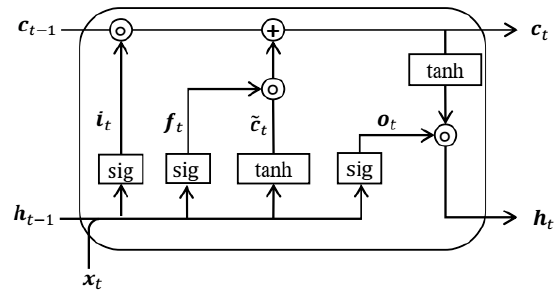
Figure 2. The architecture of the LSTM module.